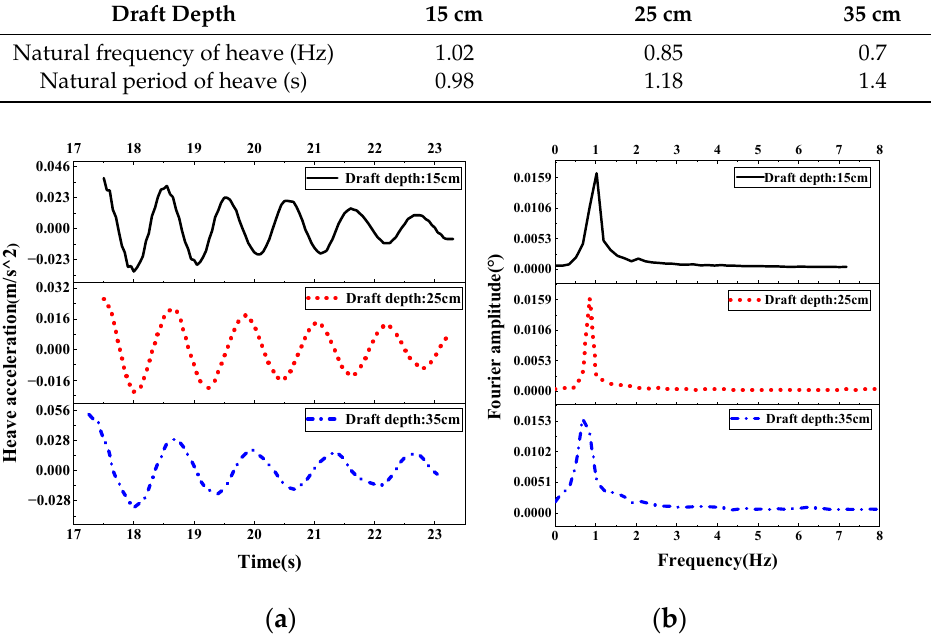
( b ) Figure 10. Natural period of roll for different drafts. ( a ) Roll attenuation curve. ( b ) Spectrum dia ‐ gram of roll attenuation.